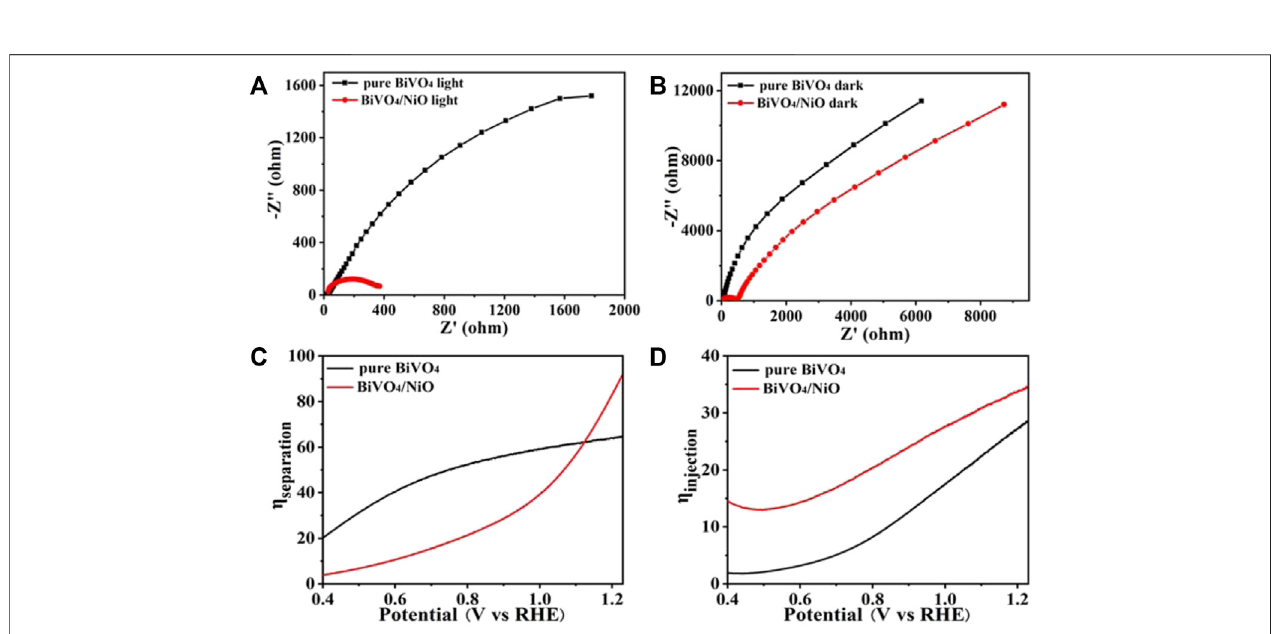
FIGURE 4 | (A) EIS curves of pure BiVO (B) and in the dark. The EIS was measured at 1.23 V vs. RHE under an AM 1.5G solar 4 and BiVO 4 /NiO under the light, simulator. (C) Charge separation ef fi ciency versus potential curves and (D) charge injection ef fi ciency versus potential curves of BiVO 4 , BiVO 4 /NiO.